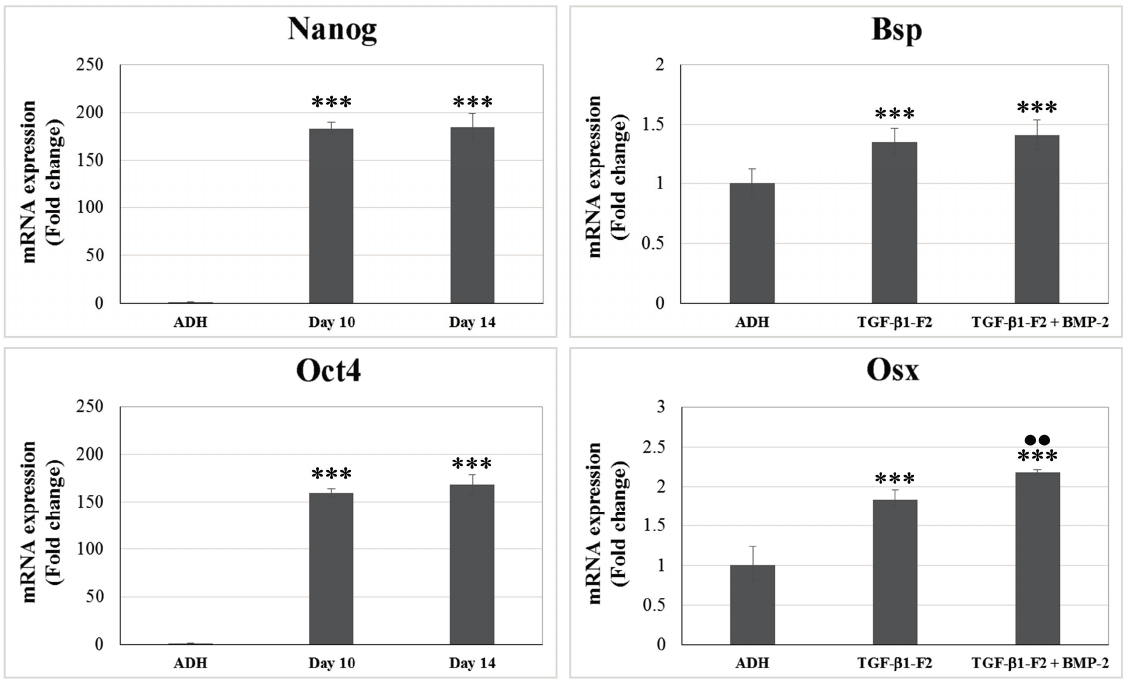
Figure 4. mRNA expression in 3D and ADH (adherent culture) cultures by quantitative real time RT-PCR (RT-qPCR). rhTGF- β 1-F2-treated cells expressed Nanog, Oct4 and